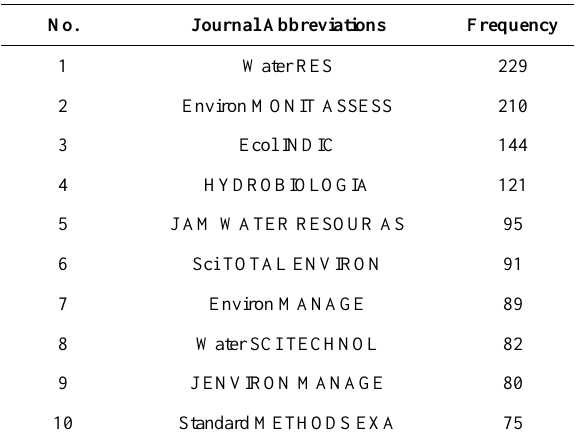
Table 1. Top 10 cited